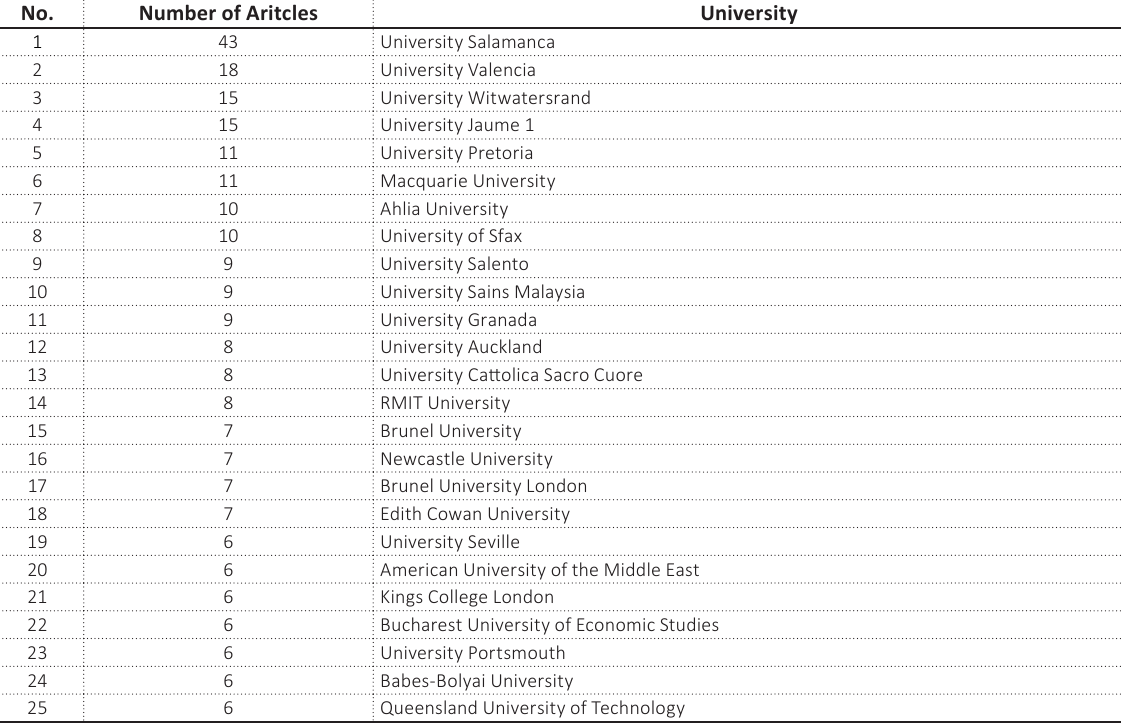
Table A1. Statistics on the number of articles published by institutions No.